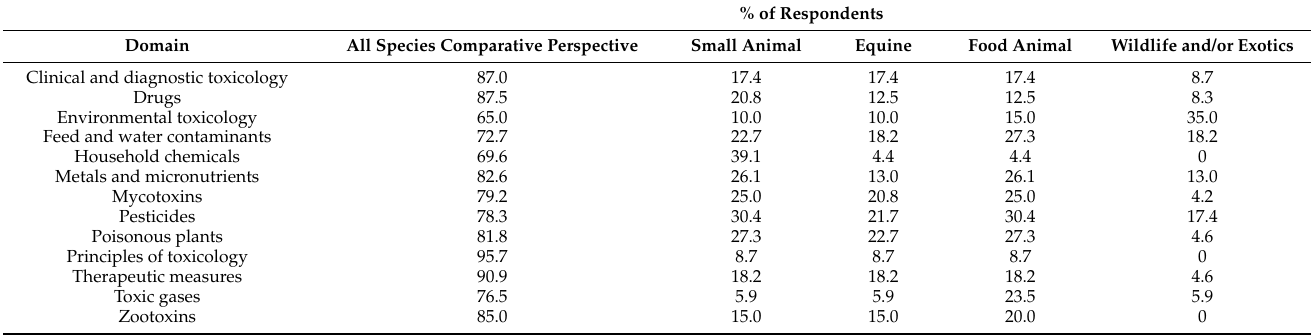
Table 2. Basic veterinary toxicology concepts and topics taught at AAVMC member institutions ( n = 24). % of Respondents